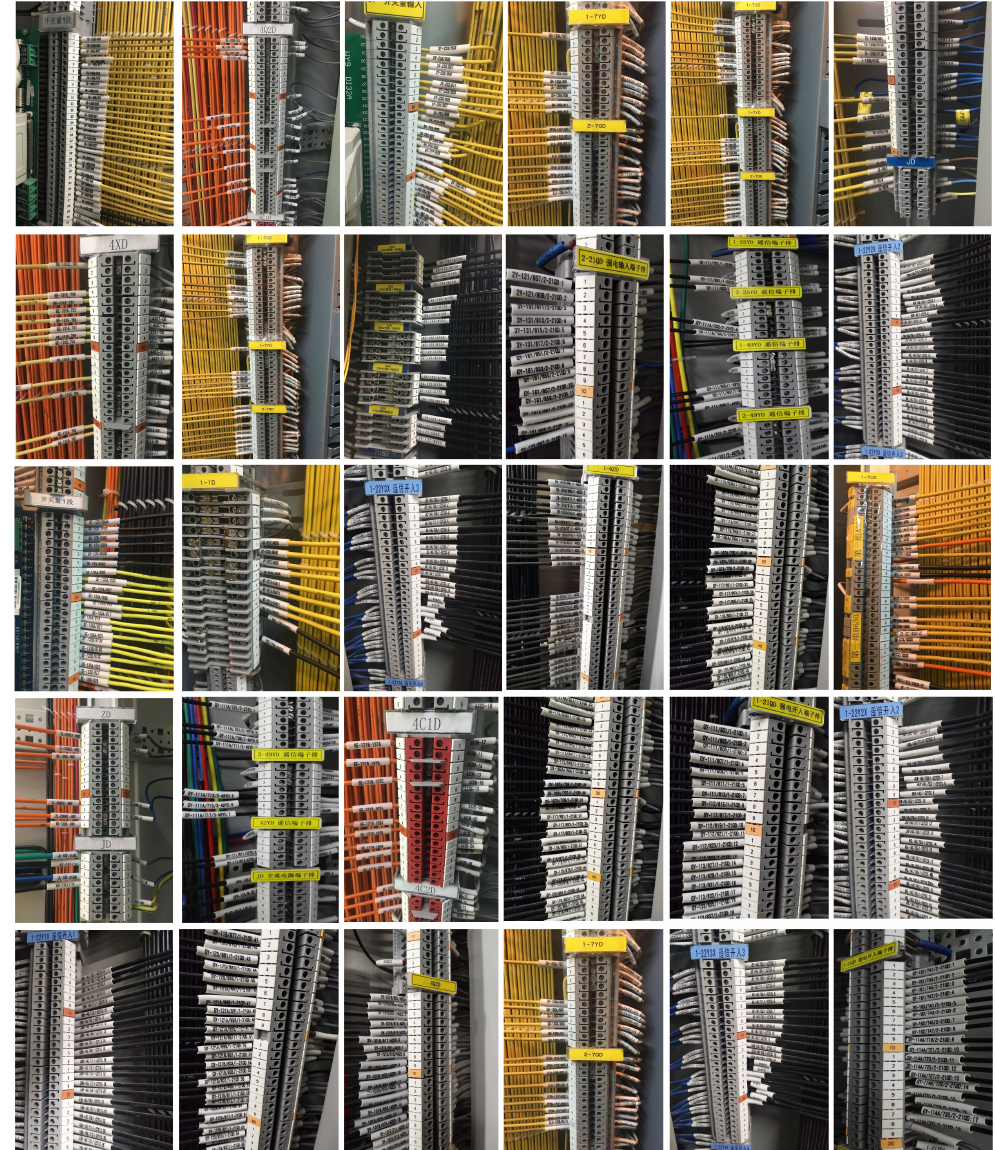
Figure 5. Some examples of the dense scene text dataset from the wiring of the terminal block of the substation panel